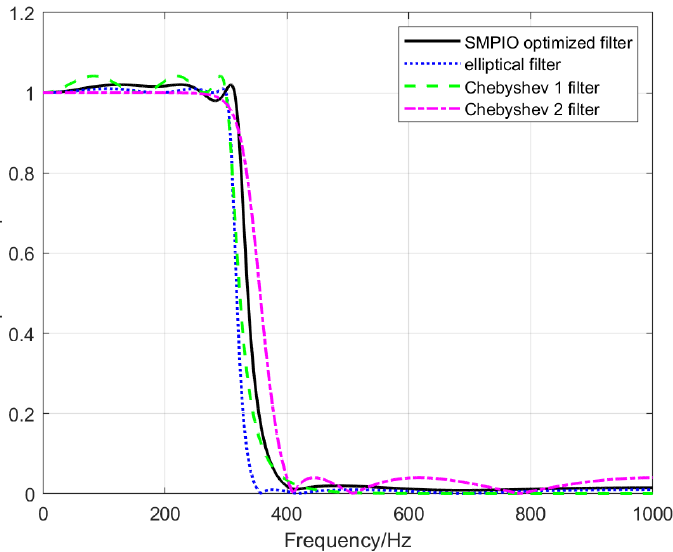
Figure 9. Amplitude response comparison of various types of filters (0 Hz~1000 Hz, m = 6, amplitude and phase optimized).